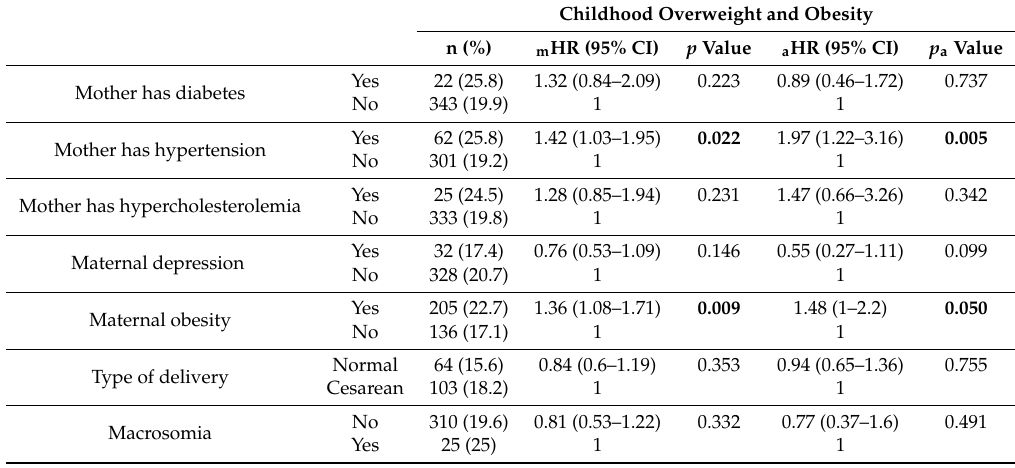
Table 4. Maternal comorbidities and gestational factors associated with overweight / obesity in children aged 2–6 years, Cear á ,